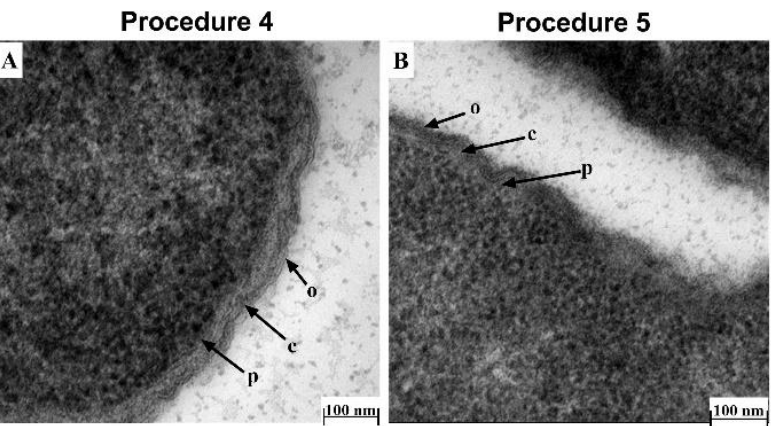
Figure 3. Effect of resin embedding on the morphology of Xen14 cells under optimized TEM conditions. TEM comparison of Xen14 morphology using cacodylate buffer and fixative containing 4.0% formaldehyde, 1.25% glutaraldehyde, 4% sucrose and 0.01 M CaCl 2 and following different embedding techniques: ( A ) LR-White resin embedding; and ( B ) Epon resin embedding. Cells clearly showed outer membrane (o), cell wall (c) and plasma membrane (p). Figure 4. Effect of fixation duration and growth medium on the morphology of Xen41 cells. TEM comparison of Xen41 morphology using cacodylate buffer and fixative containing 4.0%